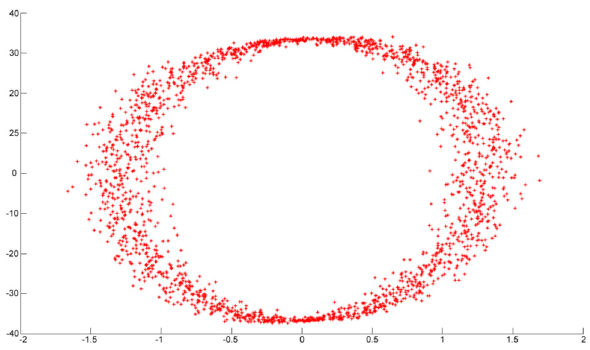
Figure 11. Chaotic trajectory for power system signal with voltage swell disturbance.